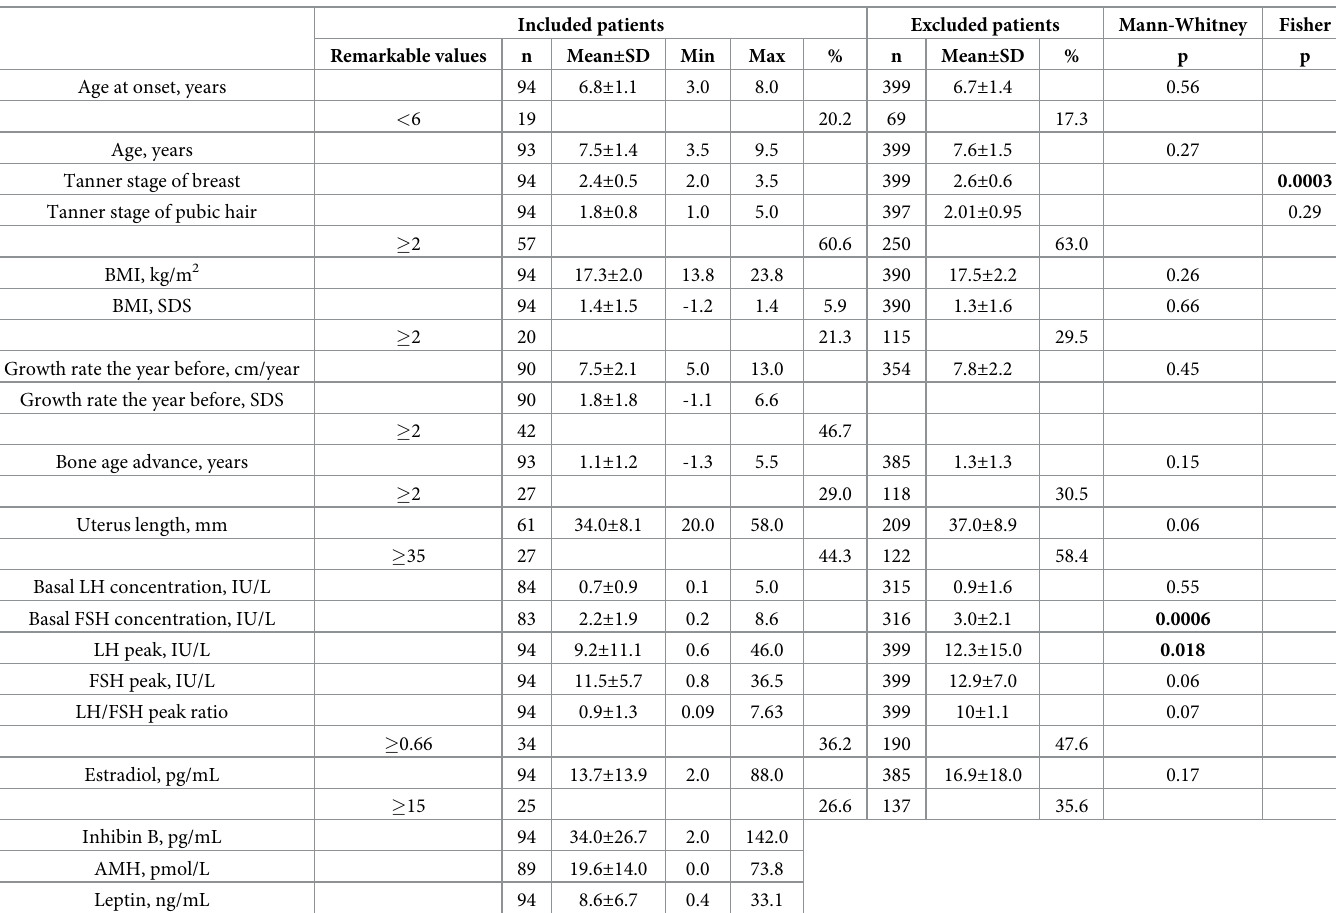
Table 1. Comparison of the characteristics at initial evaluation of included and excluded girls with CPP.